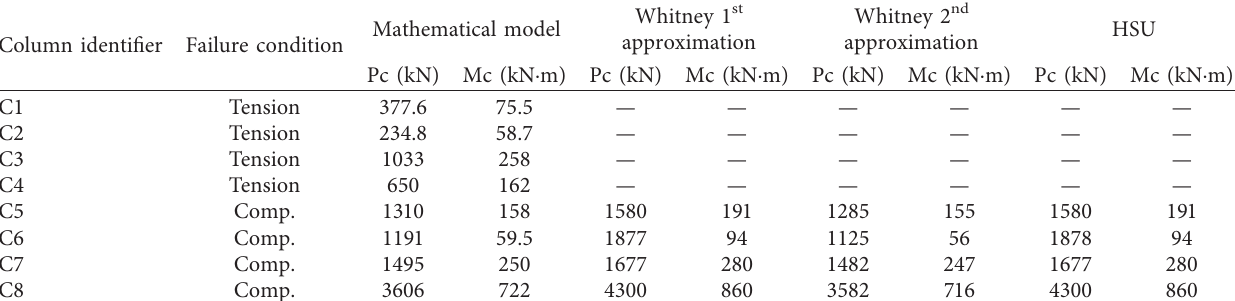
Table 3: Column design results comparison with different methods.